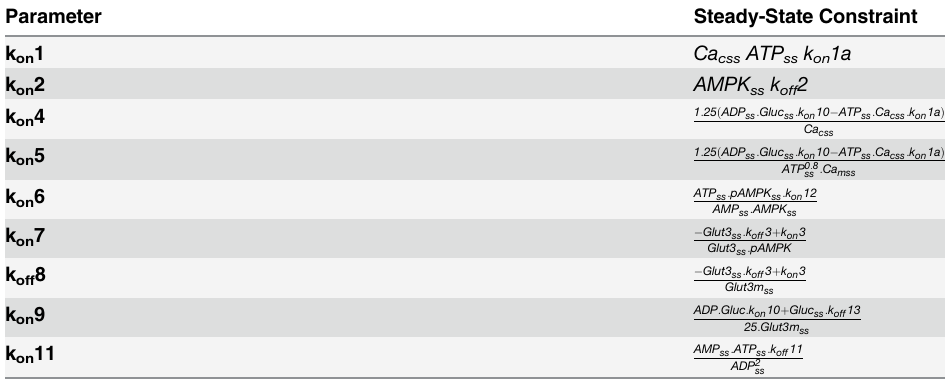
Table 3. Parameter constraints determined from steady-state (ss) analysis.